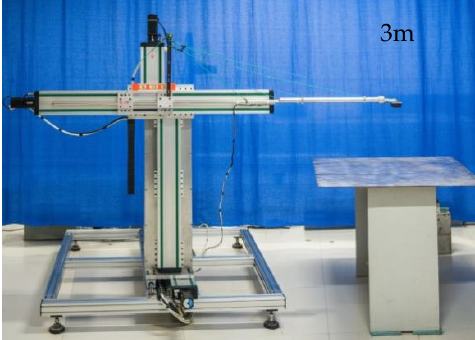
Figure 5. Ultrasonic detection results.